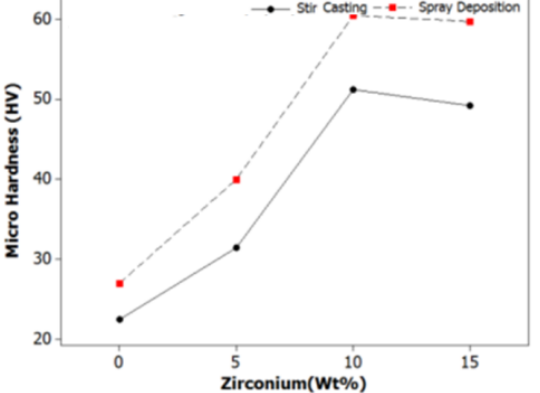
Figure 10. Micro hardness interaction plot at different processing techniques of Si-Al alloy matrix reinforced with ZrO 2 particulates for 13 wt.% Si.